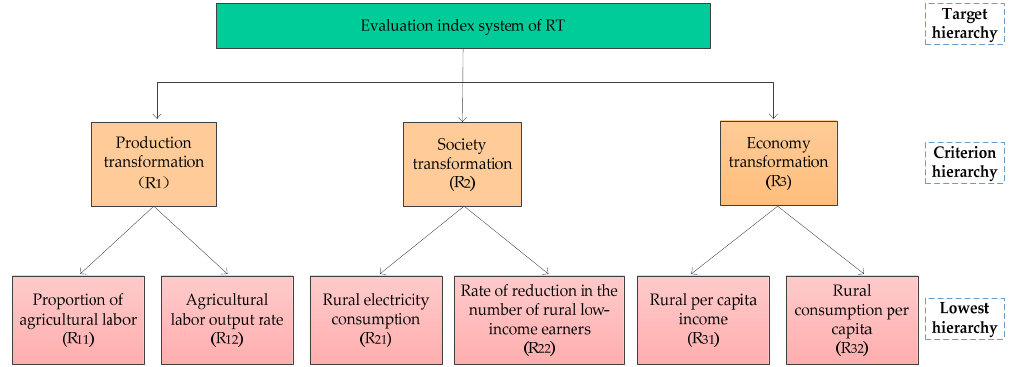
Figure 4. Evaluation index system of RT.